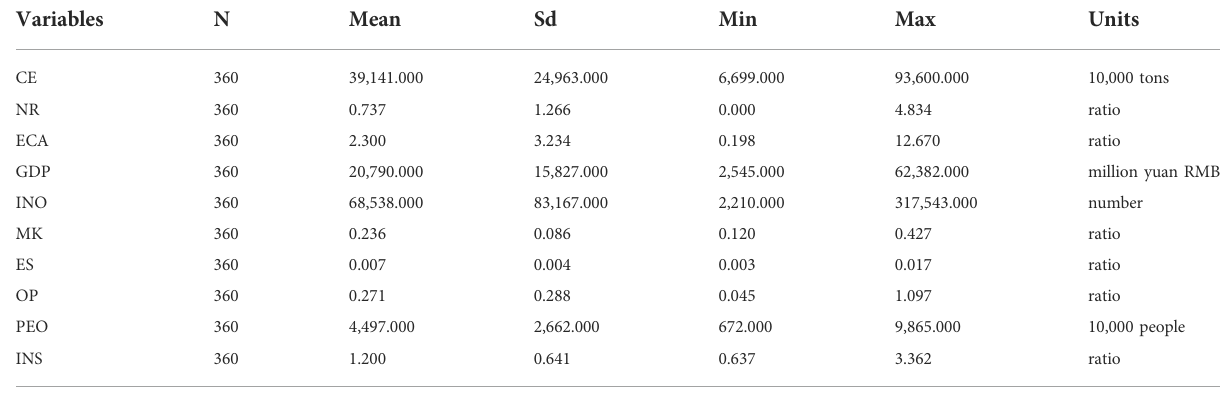
TABLE 2 Descriptive statistics for each variable.